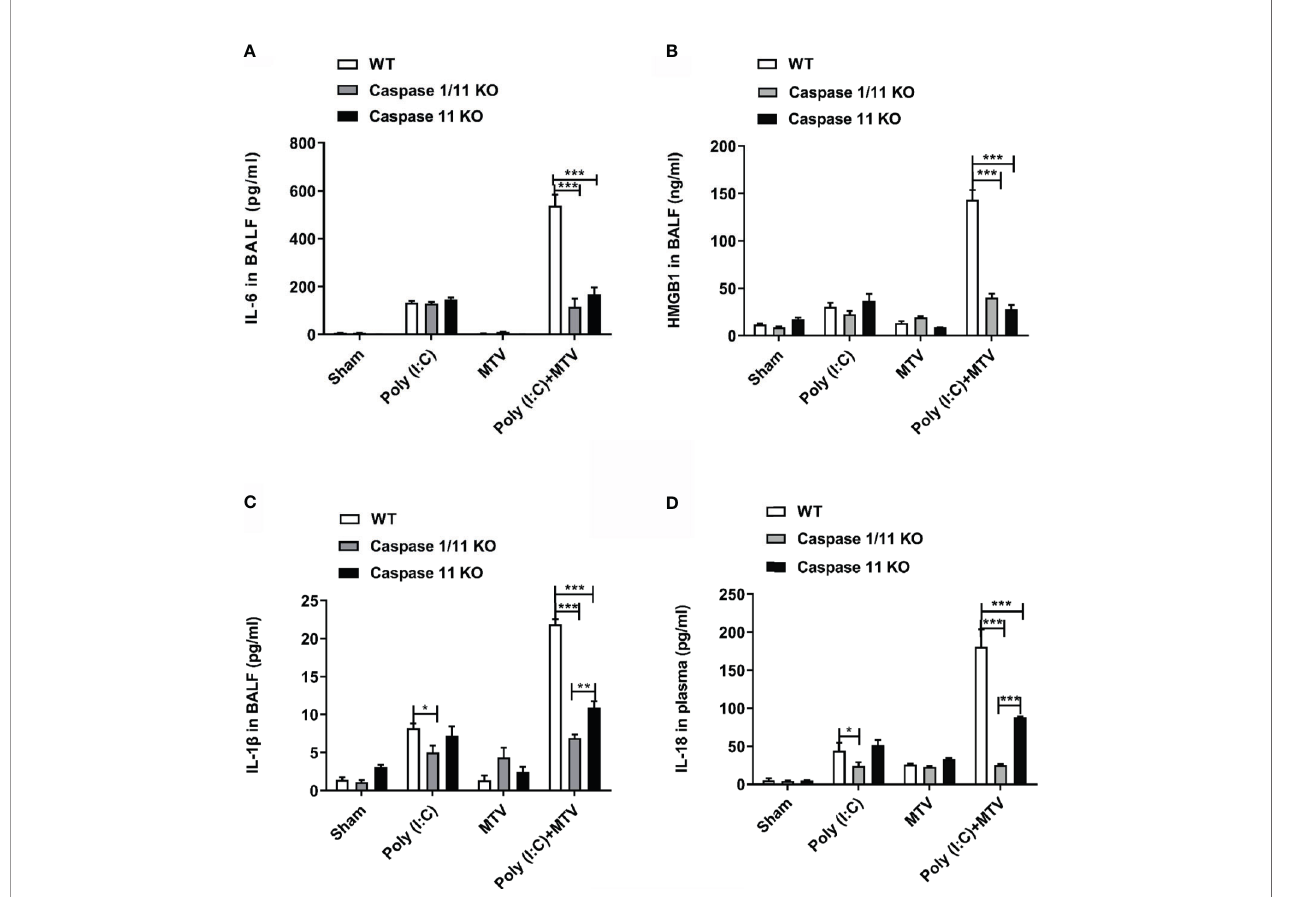
FIGURE 3 | Caspase-1 and caspase-11 alleviated Poly(I:C)-MTV induced pulmonary informatory response. IL-6 (A) , HMGB1 (n=5) (B) and IL-1 b (C) in BALF as well as IL-18 levels (D) in plasma were signi fi cantly decreased in Caspase 1/11 KO and Caspase-11 KO mice compared to WT mice. In (A, C, D) , n=6 for WT mice, n=12 for caspase-1/11 and caspase-11 KO mice. Results are shown as means ± SEM and compared by one-way ANOVA and Student-Newman-Keuls test. ** p < 0.01, *** p <